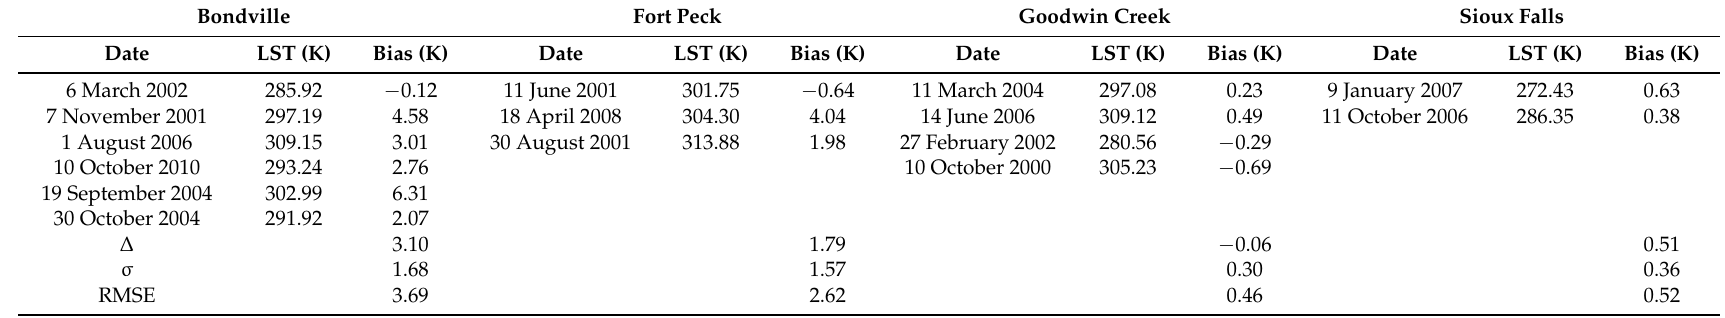
Table 11. Comparison of LST values derived from the SURFRAD stations and the LST inverted by the SCA using band 13 of the ASTER instrument. Bondville Fort Peck Goodwin Creek Sioux Falls